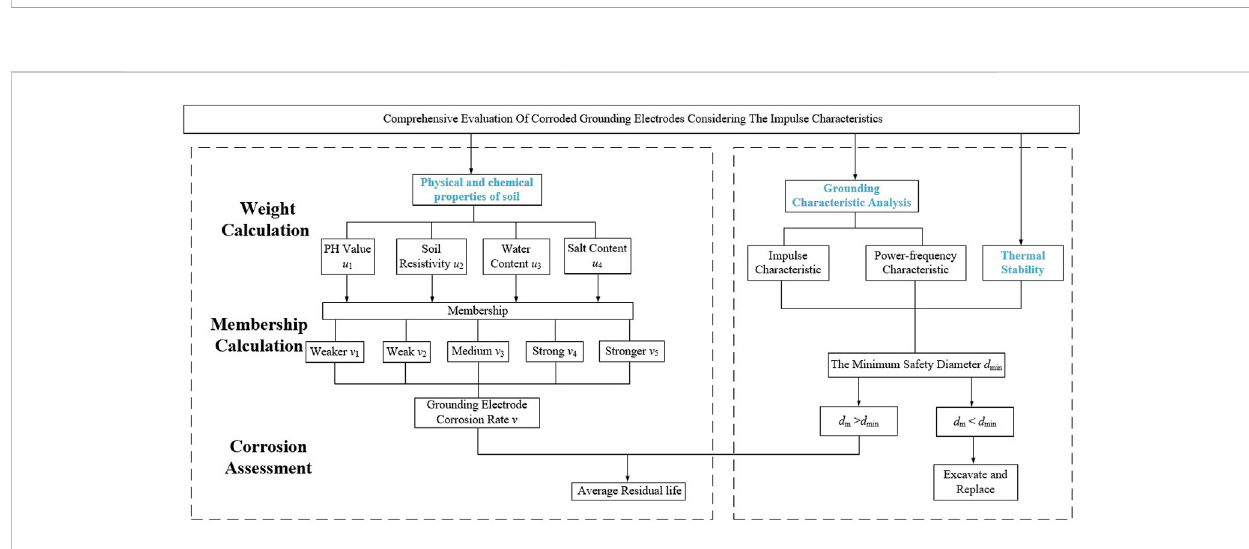
FIGURE 8 The comprehensive evaluation of corroded grounding electrodes model.